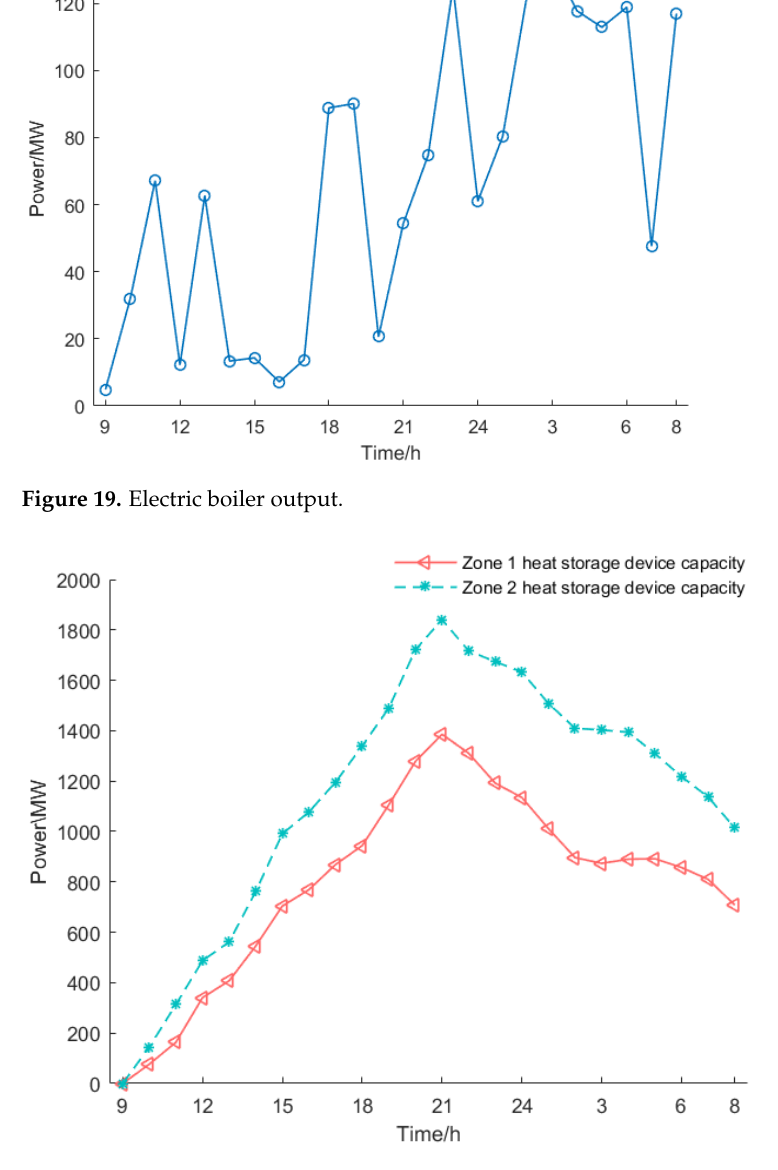
Figure 20. Heat change of heat storage device. Table 8. Comparison of various power generation